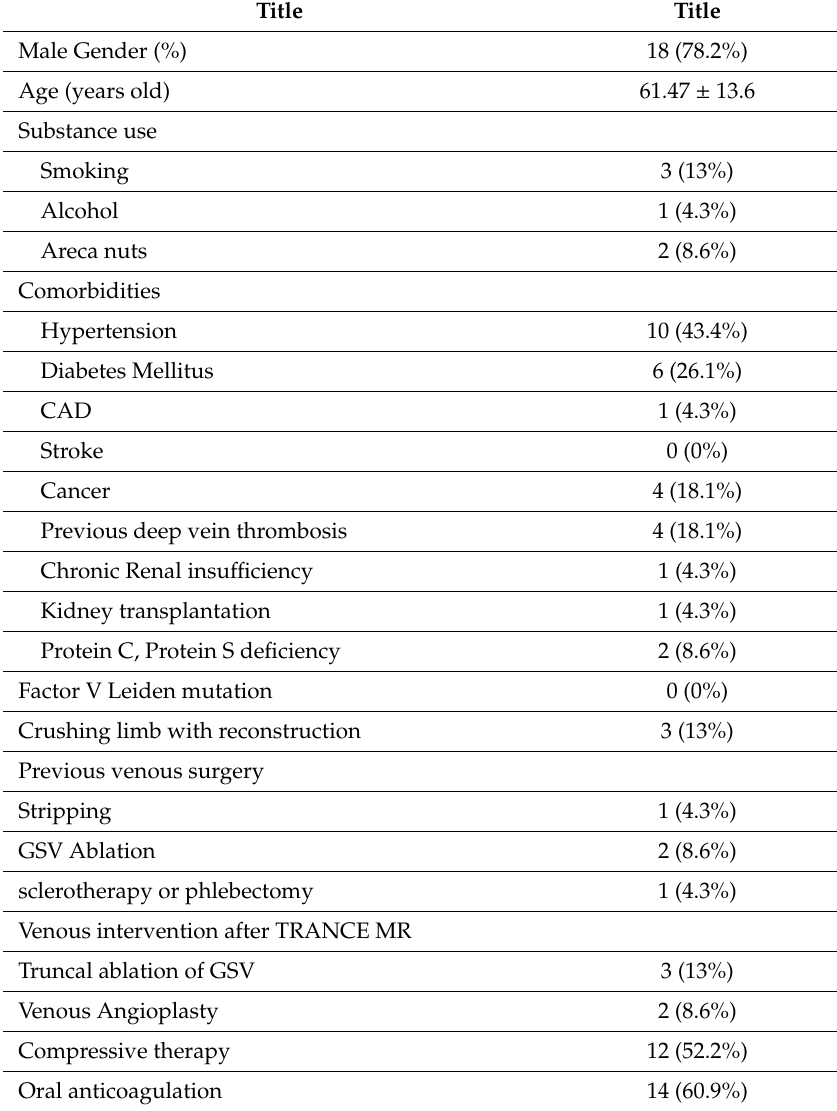
Table 1. Twenty-three patients receiving TRANCE-MRI for static ulcers in their lower